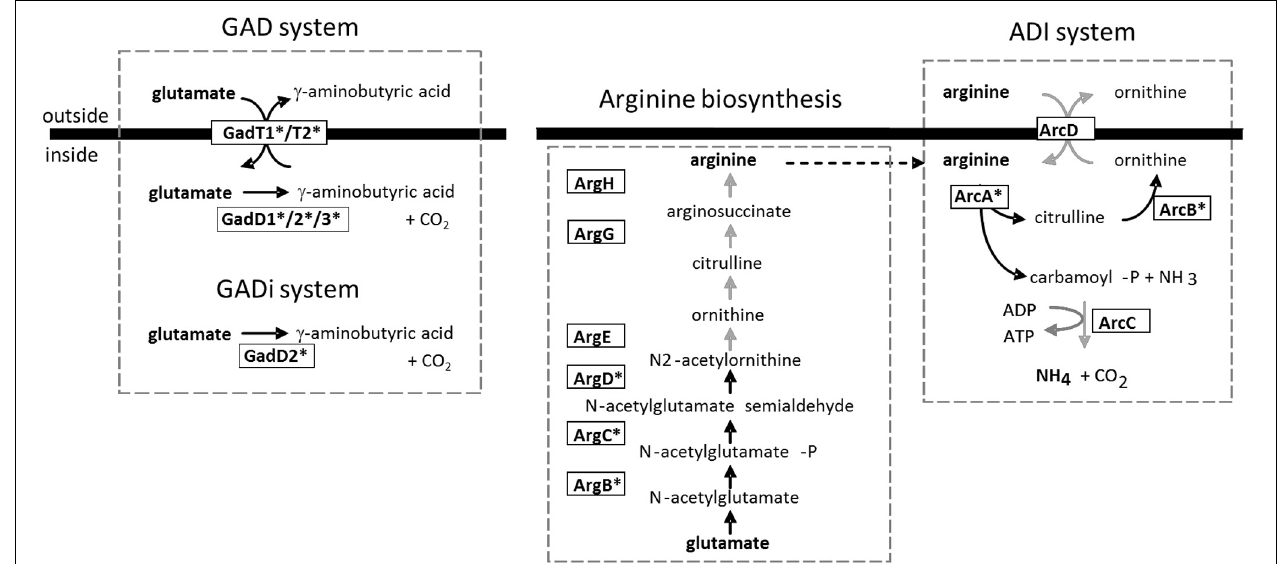
FIGURE 1 | Two major acid tolerance mechanisms in L. monocytogenes . The GAD system is proposed to function through the import of glutamate into the cell (via GadT1 or GadT2) which is converted to GABA via Gad enzymes (GadD1, D2, or D3) in the cytoplasm. The GABA is then thought to be exported from the cell by means of the antiport systems (GadT1/T2). The consumption of protons during the reaction is contributes to the reduction in intracellular hydrogen ion concentration (Cotter et al., 2001). Karatzas et al. (2012) have recently proposed the existence of an